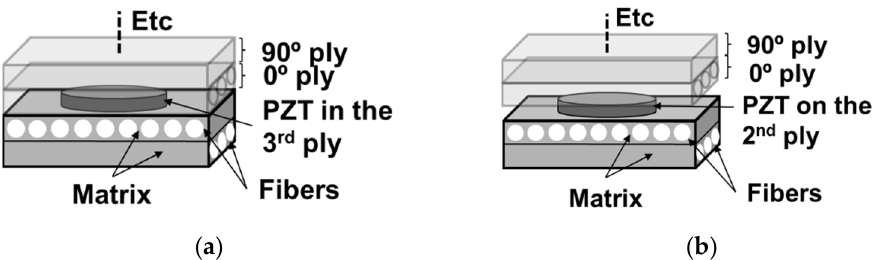
Figure 3. Integration methods tested. ( a ) Transducer directly integrated into the ply and ( b ) transducer between two plies.